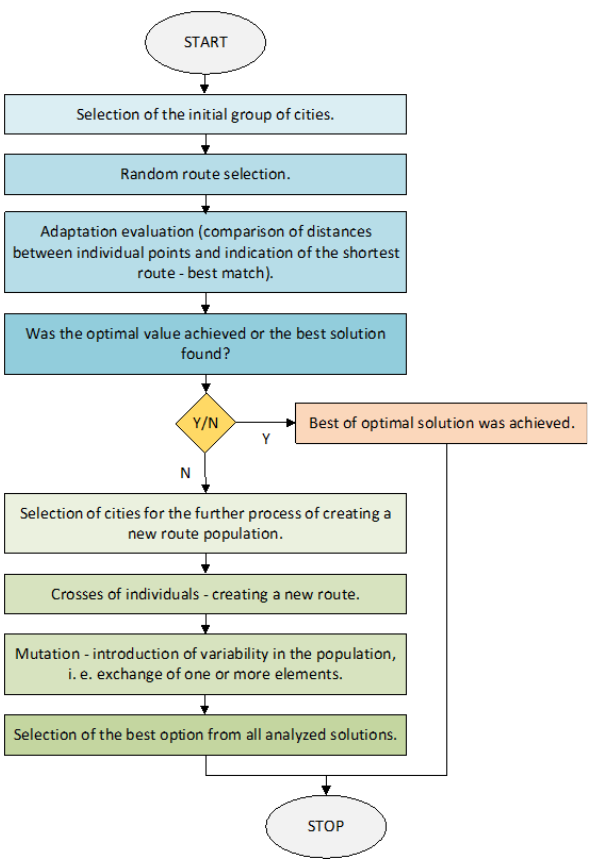
Figure 7: A diagram showing the operation of a genetic algorithm